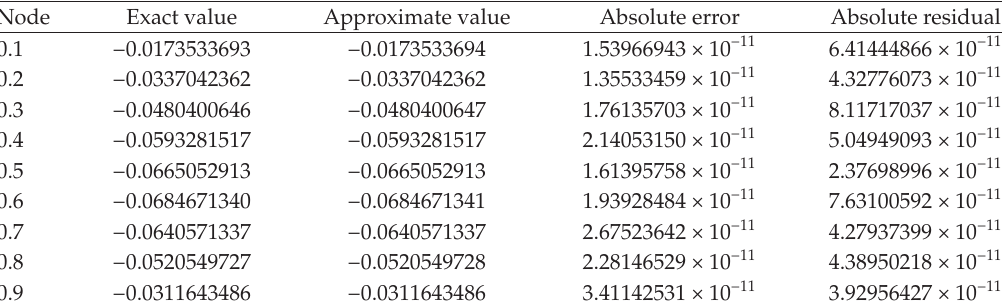
Table 5: Numerical results for Problem 3.